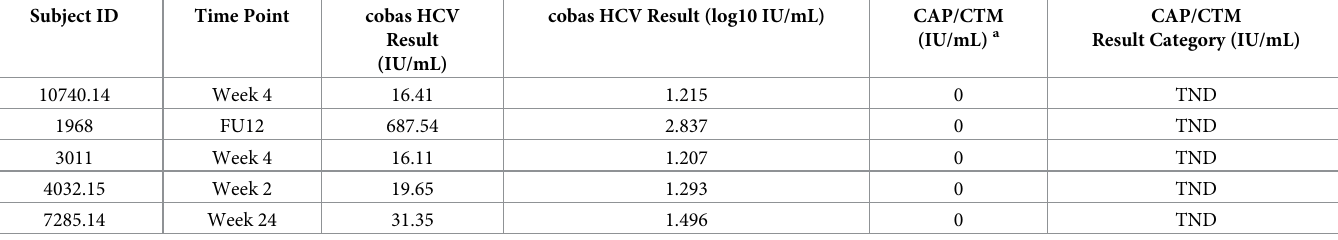
Table 1. Sample listing for cobas HCV in samples with CAP/CTM target not detected (TND); n =